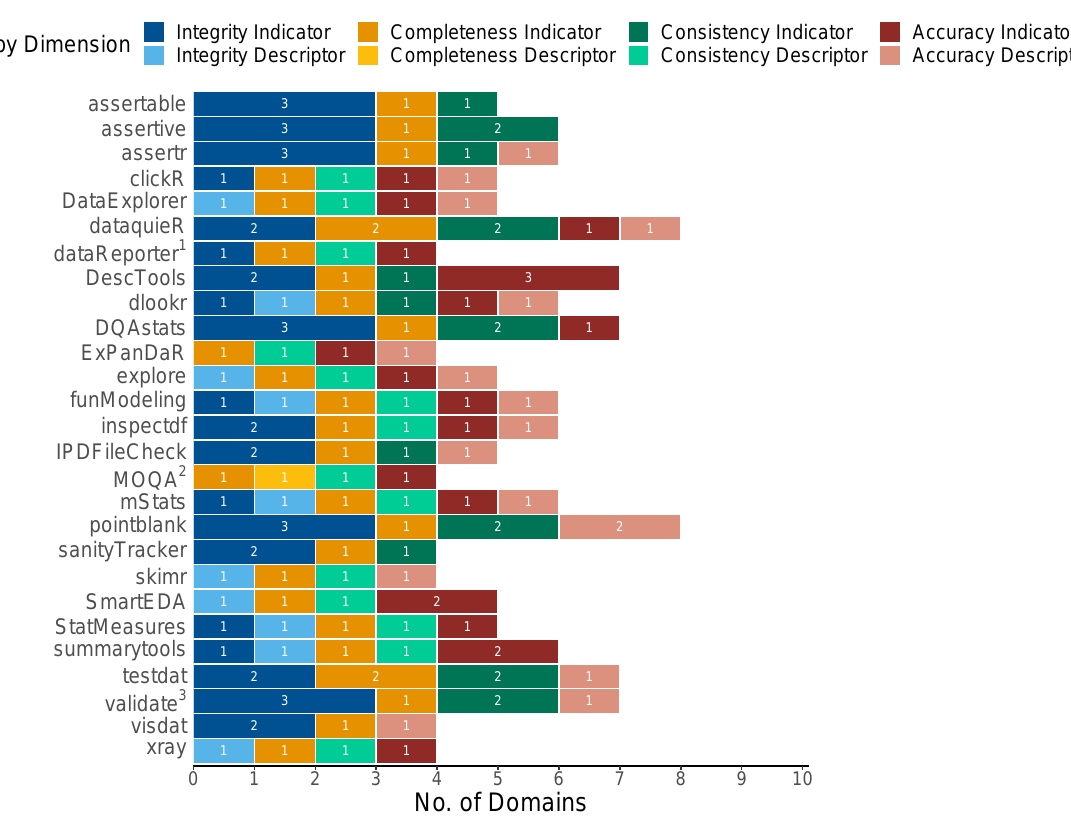
Figure 3. Number of data quality dimensions and domains for which inferences can be made based on the output of each of the 27 packages included in this review. For each package, the numbers correspond to the number of covered domains within each dimension. If a domain is covered by indicators and descriptors, the descriptors are not mentioned separately, yet Tables A1–A7 provide the detailed information. 1 identical with dataMaid , 2 first published as mosaicQA , 3 includes integration with errorlocate